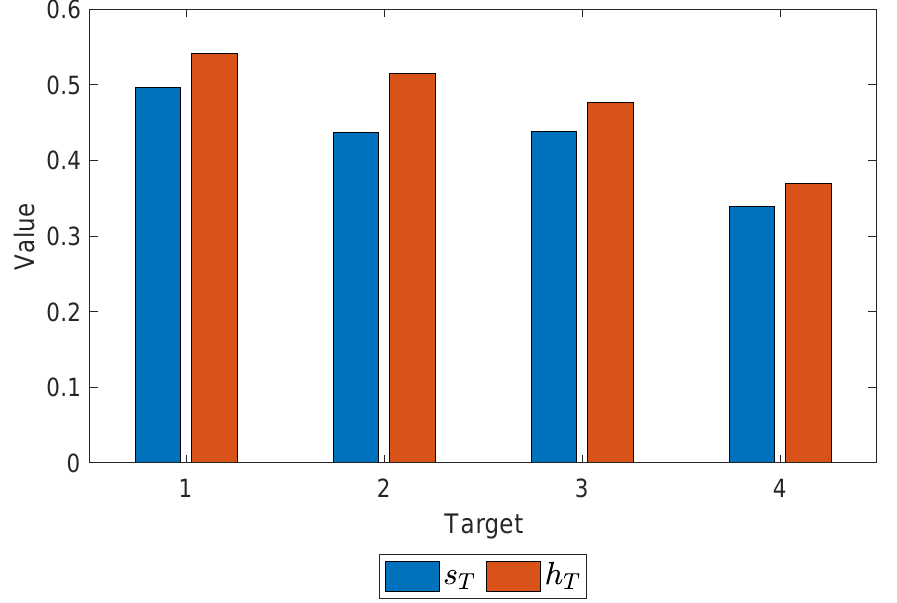
Figure 5. The score values and exact values for the targets under the G-GGSC g